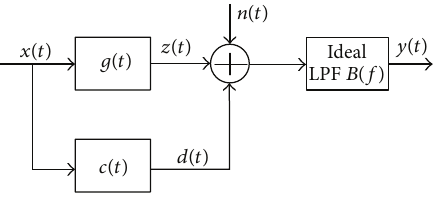
Figure 1: Signal model of a target ensemble in signal-dependent